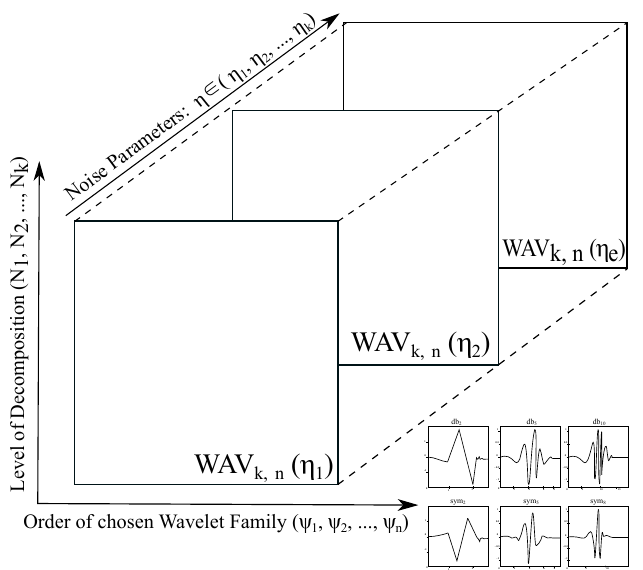
Figure 7. A general scheme of volumetric (4D) modelling for 2D distribution of Wavelet